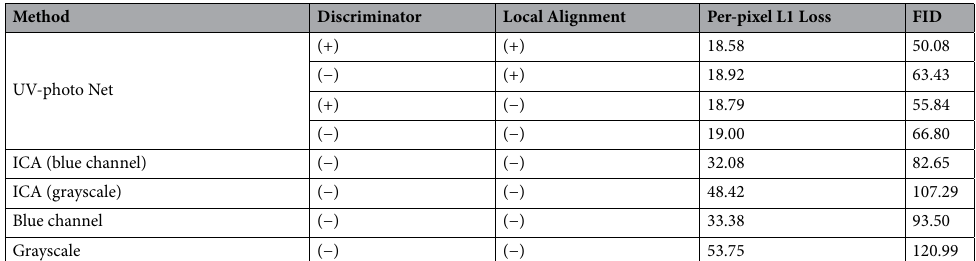
Table 2. Per-pixel L1 loss and Fréchet Inception Distance (FID) for synthetic UV images generated by UV-photo Net, grayscale images, blue channel images, and images obtained with the ICA-based method (grayscale and blue channel) ( + ) denotes the case using the corresponding learning technique for training, while (−) denotes the case without the corresponding learning technique.